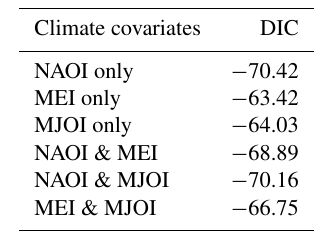
Table 1. DIC values for each iteration of the model runs. Intensity and SST are included in all